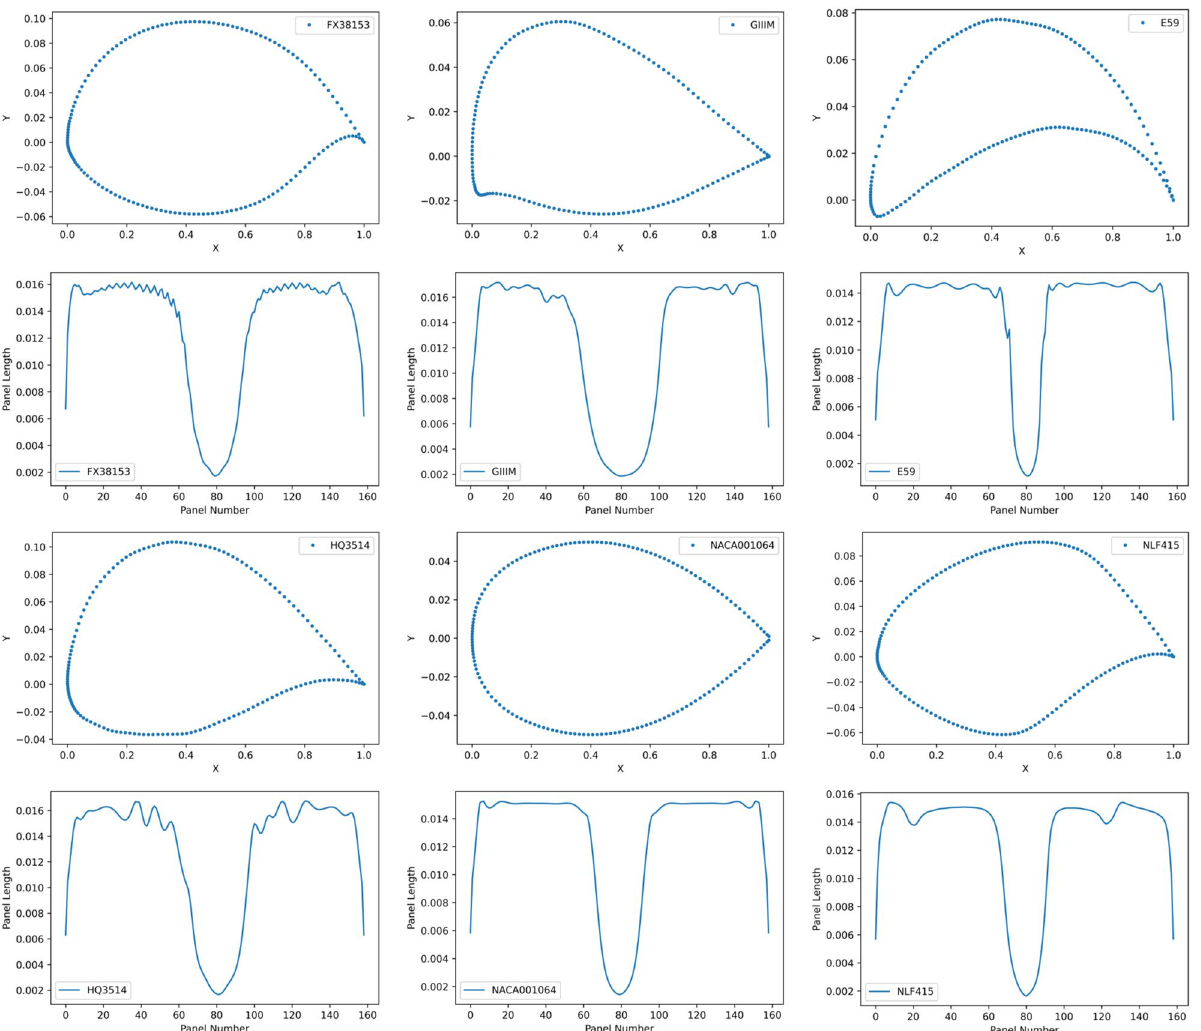
Figure 11. Randomly sampled airfoils and their panel length distribution.